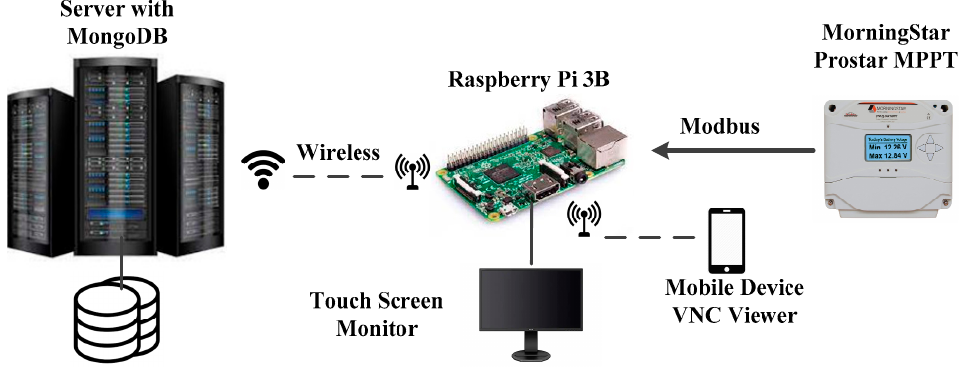
Figure 5. Data Communication.